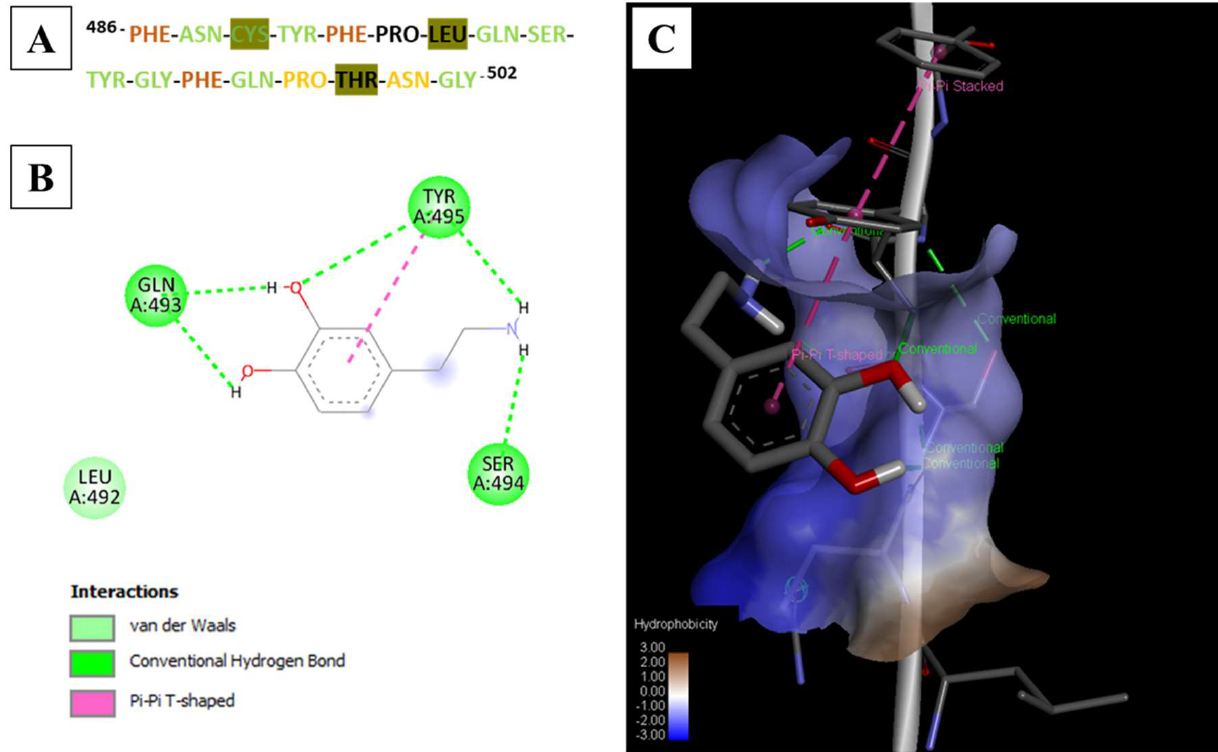
Figure 2. ( A ) Representation of types of interactions of dopamine with each amino acid residue (shown with one letter code) that are actively involved in H−bonding (green) and van der Waals interactions (black letters highlighted with green). When all the docking poses were visualized, res- idues were also shown to be involved in more than one type of binding interaction such as H−bond- ing with π–π interactions (brown) or van der Waal forces (yellow). The binding of most favorable docked pose with the peptide with a binding energy of −3.4 kcal/mol mapped in ( B ) 2D and ( C ) 3D, where green dotted lines represent hydrogen bonds, purple/pink areas represent π–π bond interac- tions, and blue areas represent solvent accessible surfaces.